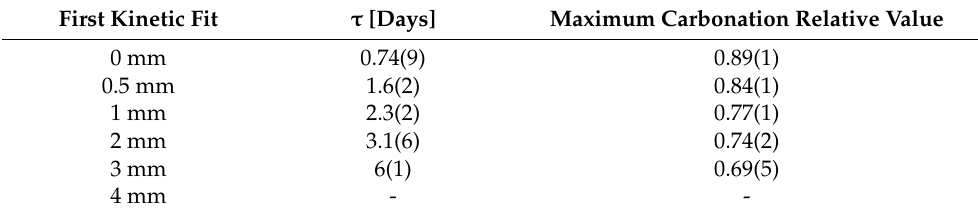
Table 1. Fit parameters of the carbonation curve in